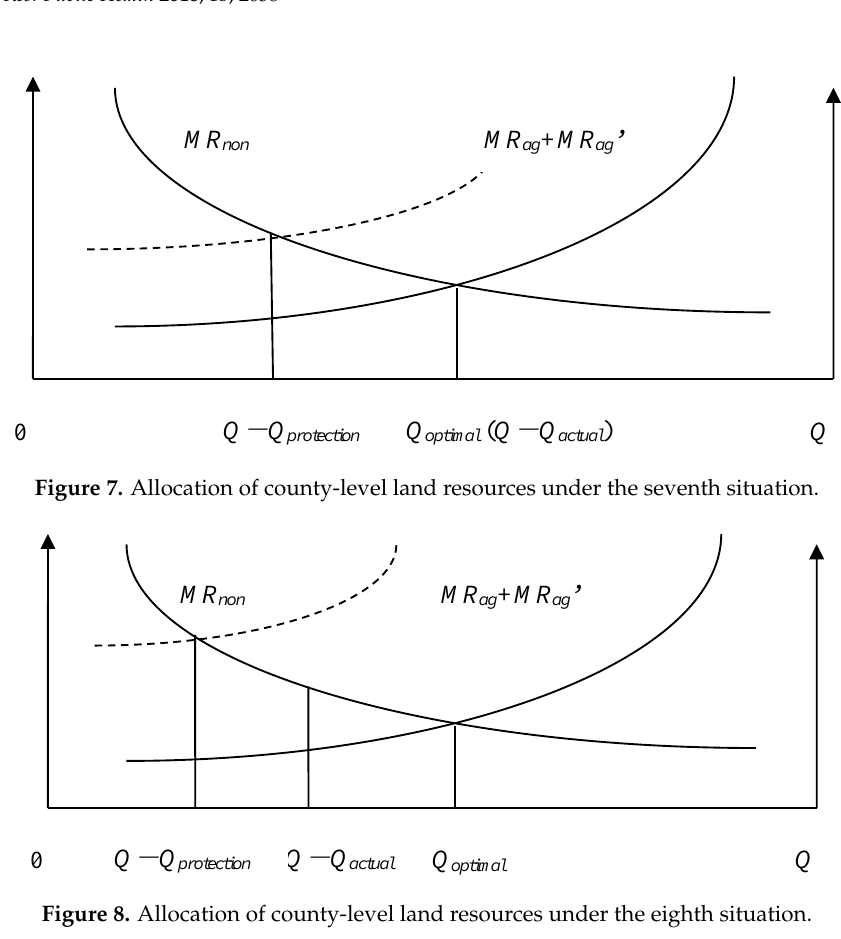
Figure 8. Allocation of county ‐ level land resources under the eighth situation.